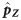
Revised estimates of cumulative pZ versus empirical p^Z by country.Countries to the left of the dotted line reported zero confirmed or suspected Zika cases according to PAHO. Top: Total reported Zika cases by country on a log10 scale. Bottom: Violin plots of cumulative pZ assuming confirmed cases arose from PCR-RT or IgM tests only, with empirical p^Z indicated with a horizontal orange line. The distributions of pZ were estimated using temporally disaggregated data for each country and were then were aggregated for visualization. Region-wide estimates (i.e., aggregated across all 43 countries) are shown farthest to the right.